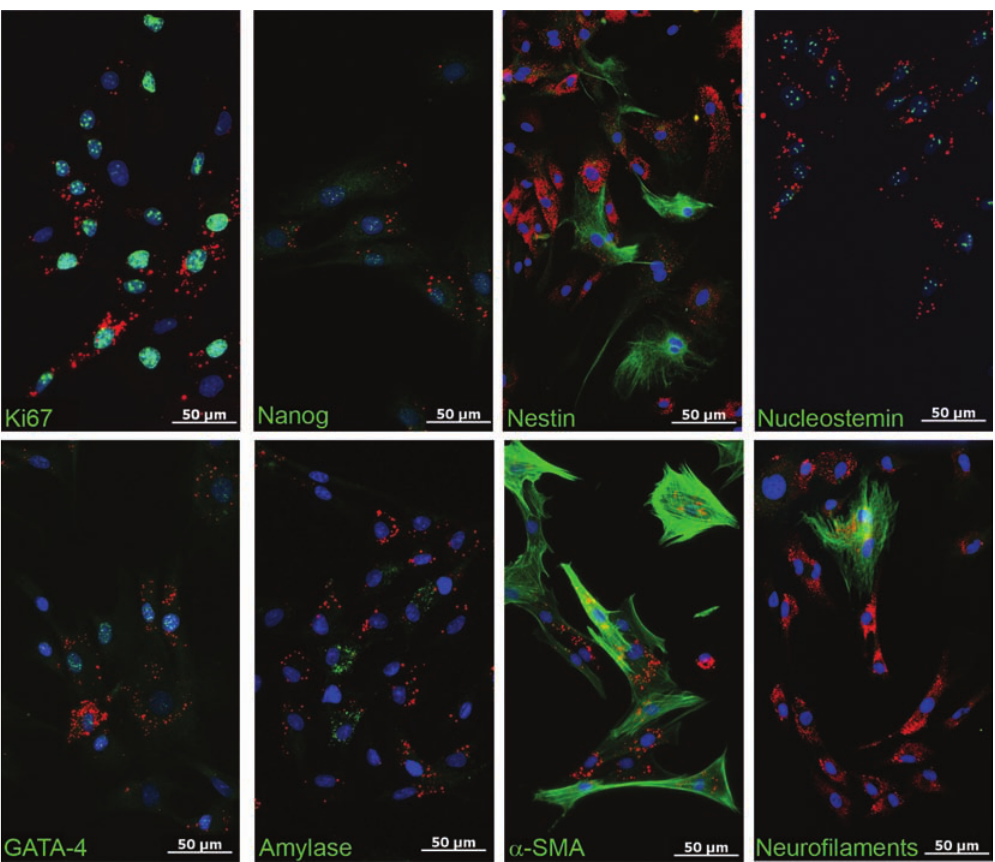
Figure 11: Immunocytochemical localization of stem cell and lineage specific proteins (green) in QD labeled (red) stem cells. QD labeled cells stained positive for nuclear (Ki67, Nanog, Nucleostemin, GATA-4), secretory (Amylase), and filamentous proteins (Nestin, 𝛼 -SMA, Neurofilaments) indicating spontaneous in vitro differentiation. Nuclei were stained with DAPI